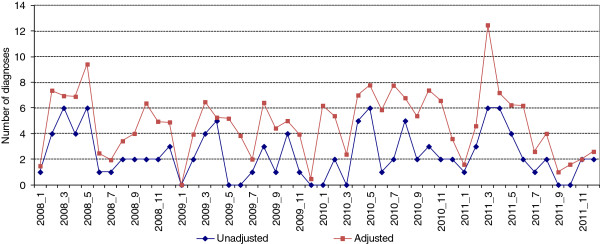
HIV-positive diagnoses among MSM (unadjusted and adjusteda) by month, Ottawa, 2008-11.